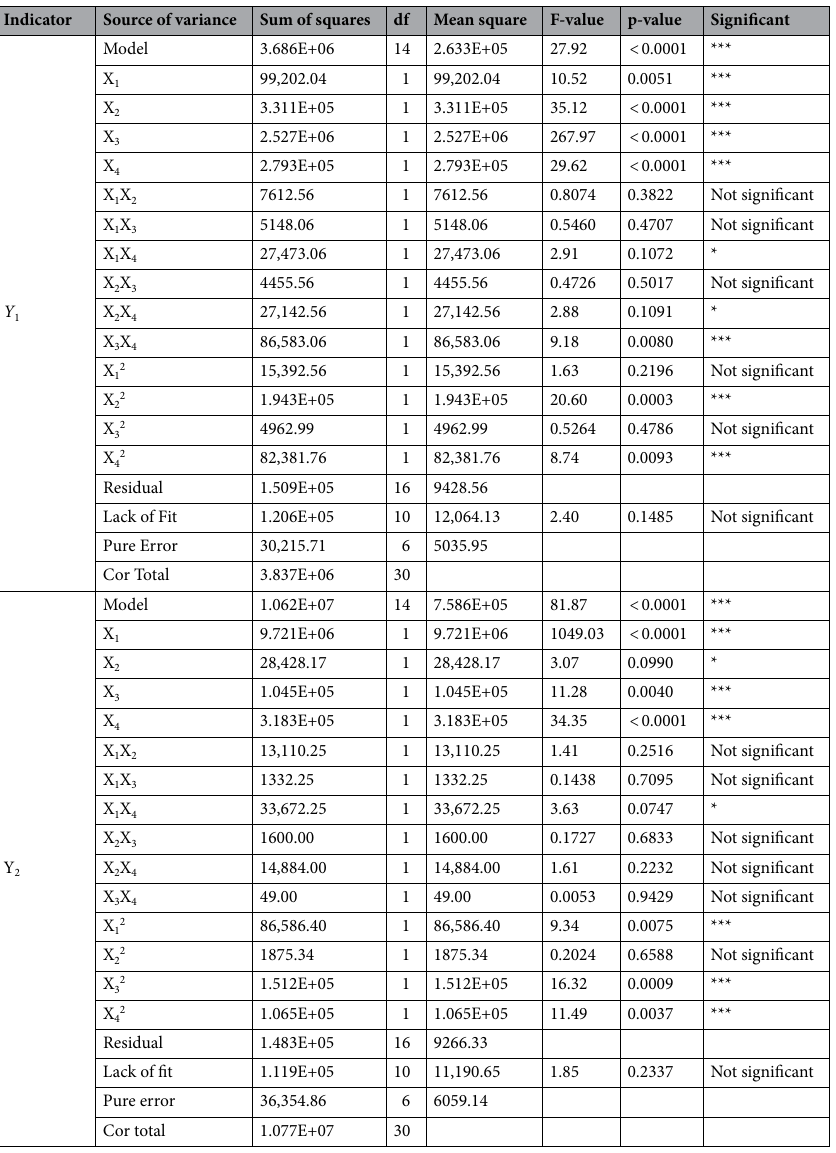
Table 5. ANOVA results of regression model. ***Means extremely significant (P < 0.01); **Means very significant(0.01 ≤ P < 0.05); *Means significant(0.05 ≤ P < 0.1). “df” means degree of